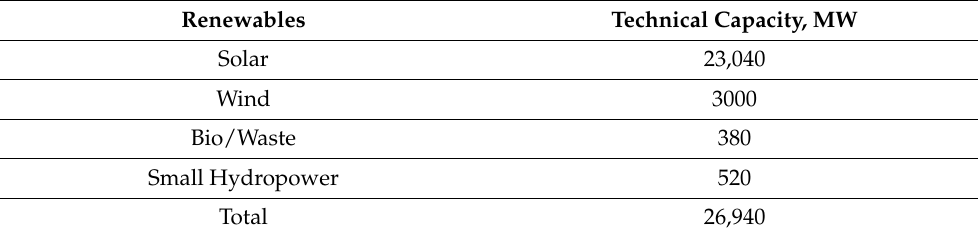
Table 8. Renewable resources potential in Azerbaijan (by IRENA)